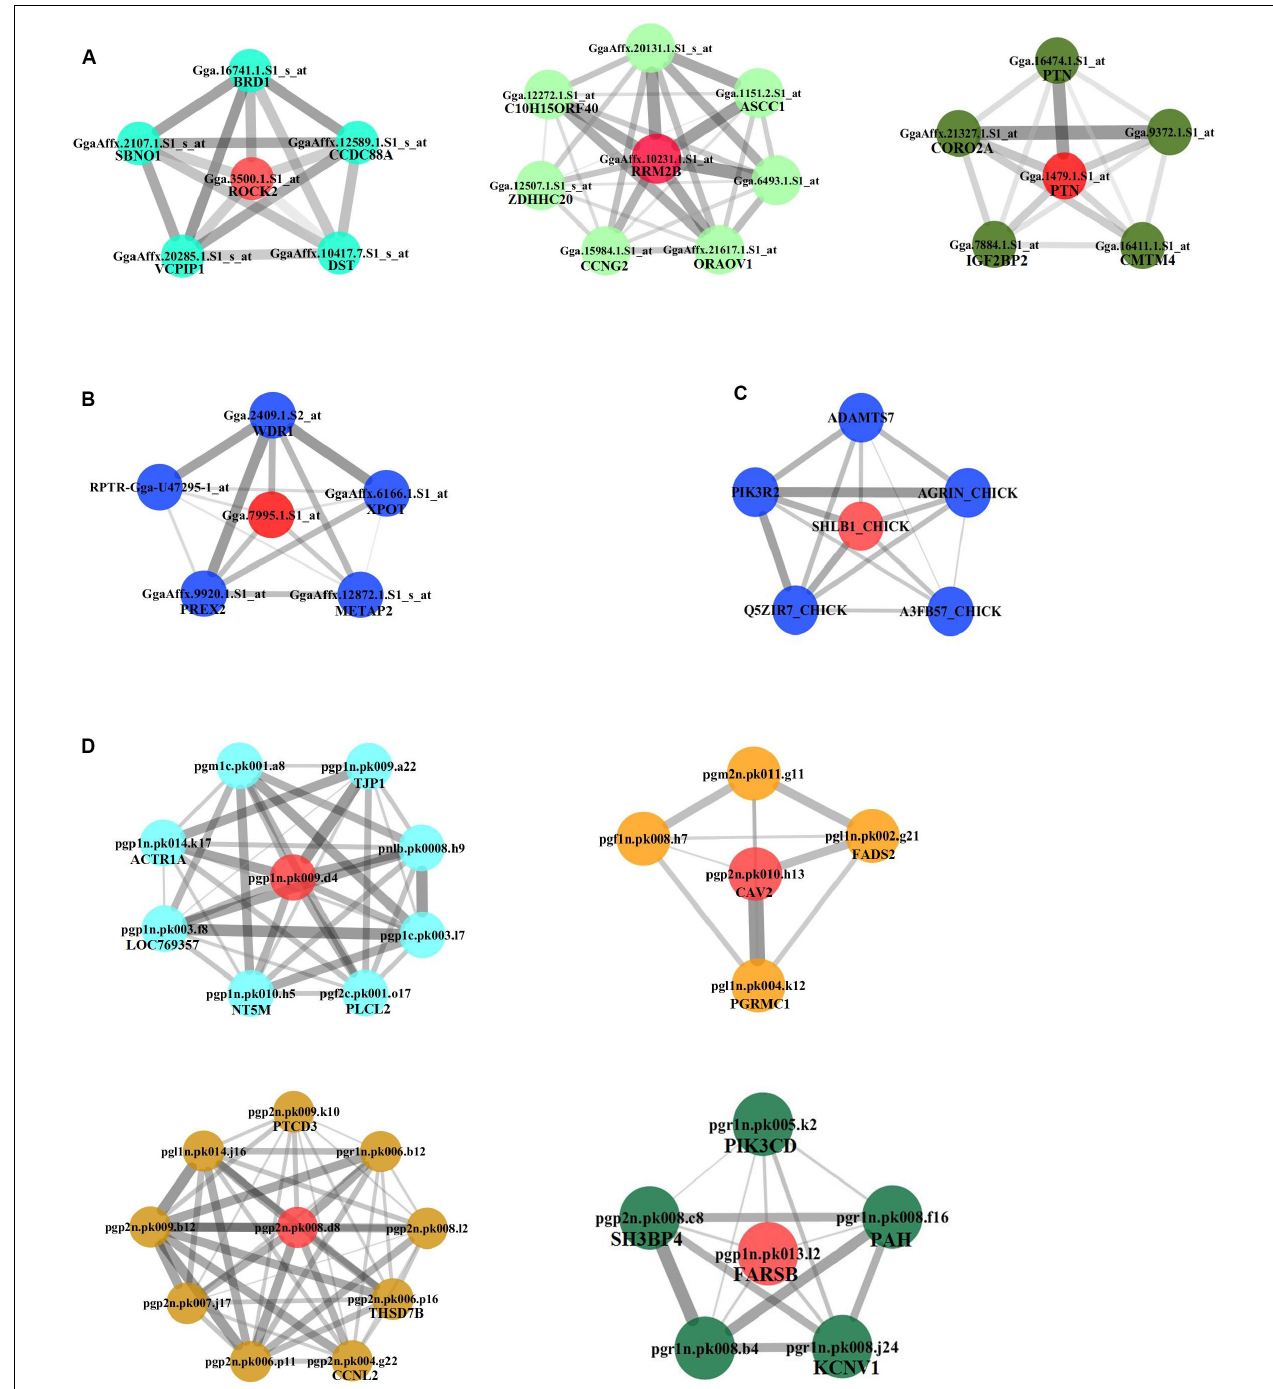
FIGURE 3 | Subnetworks constructed for hub genes. Direct gene neighbors of the hub genes were extracted for building subnetworks. Four subnetworks were built. (A) NEAUHLF: preadipocyte microarray. (B) NEAUHLF: adipose tissue microarray. (C) French: adipose tissue RNA-seq. (D) French: adipose tissue